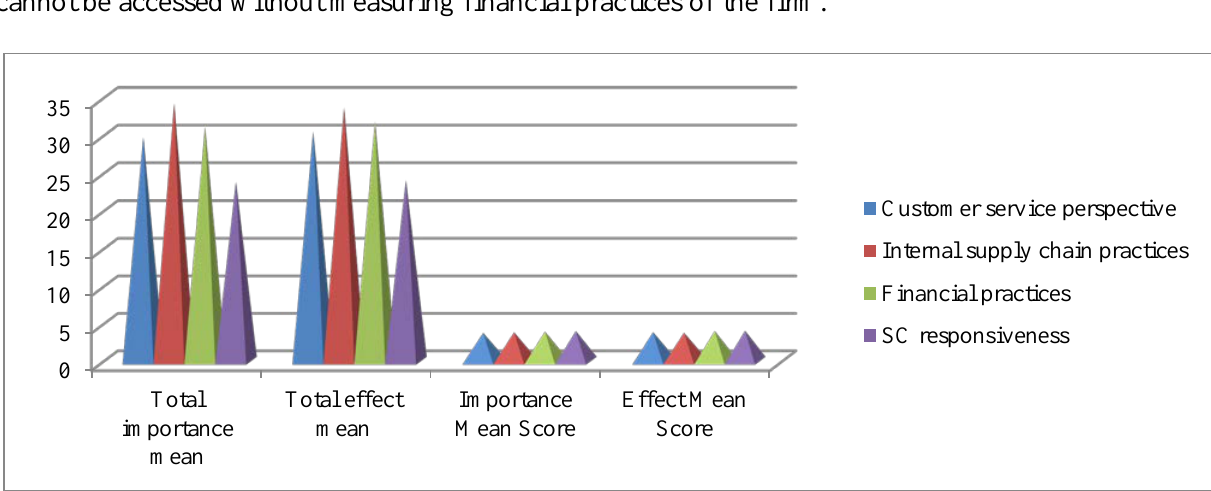
Fig. 10. Individual & total importance and effect mean for SCP